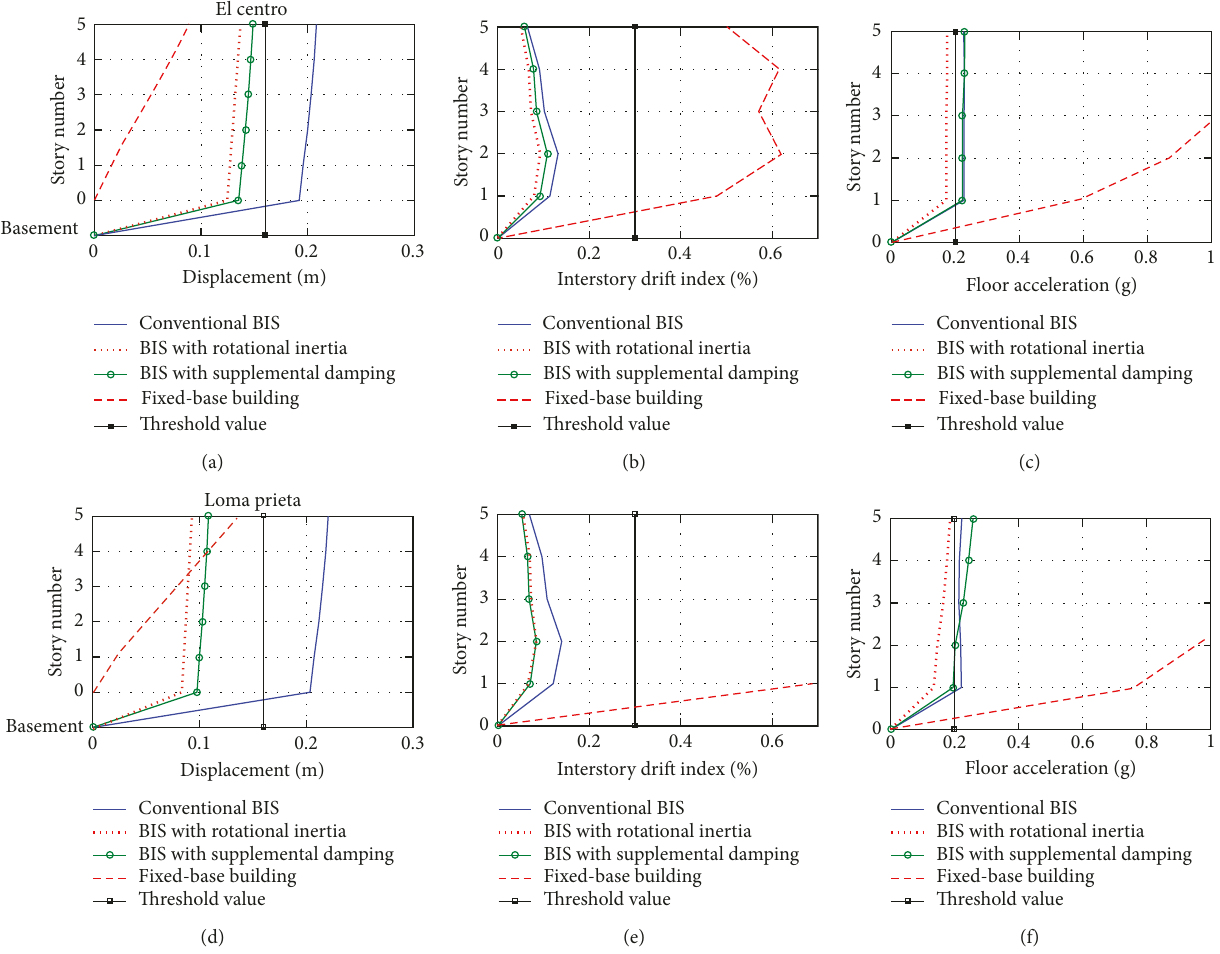
Figure 19: Average maximum distribution of horizontal displacements (a, d), interstory drift index (b, e), and floor acceleration (c, f) for El Centro and Loma Prieta earthquake ground